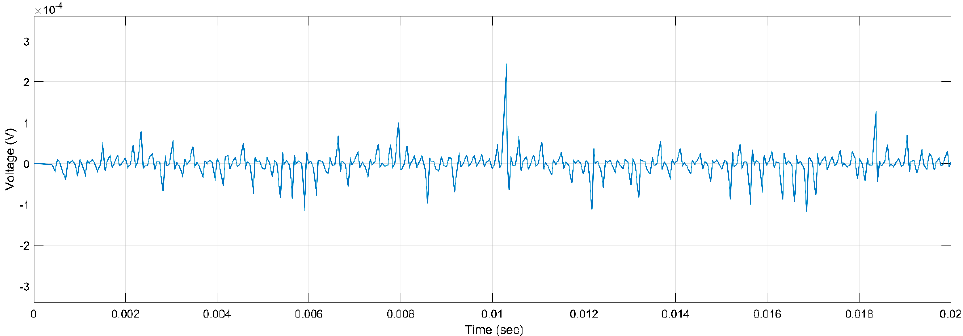
Figure 21. PD Activity for Combination, 15 kV, 2 h, r.